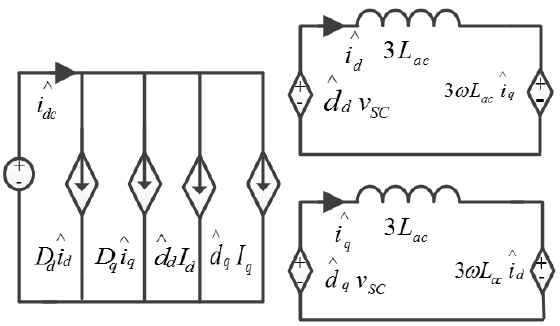
Figure 5. Small-signal equivalent model of the DC/AC converter in d - q space.